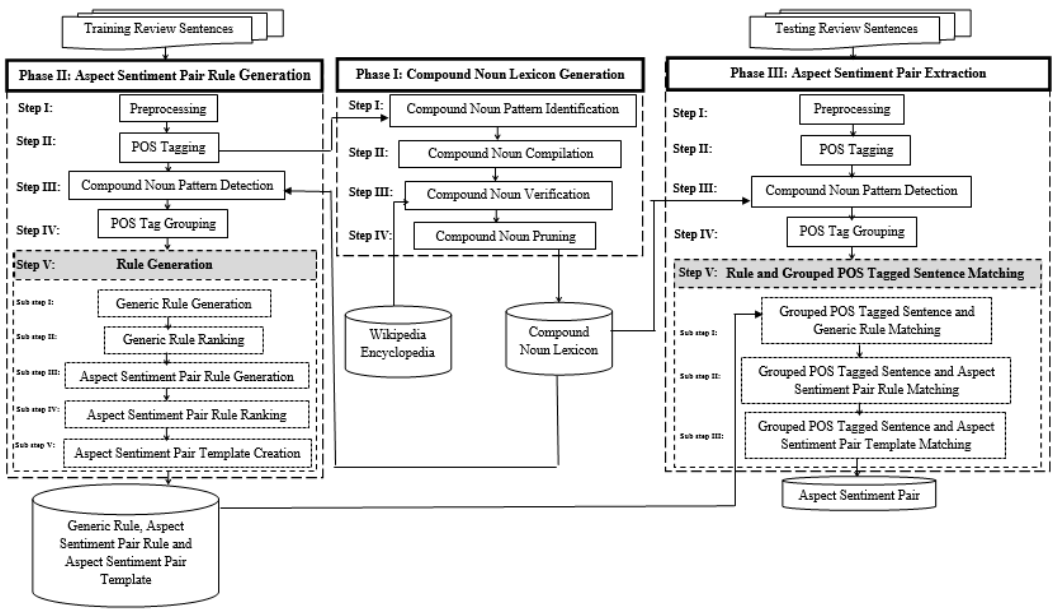
Figure 1. The aspect-sentiment pair extraction using rules and compound noun lexicon (ASPERC)